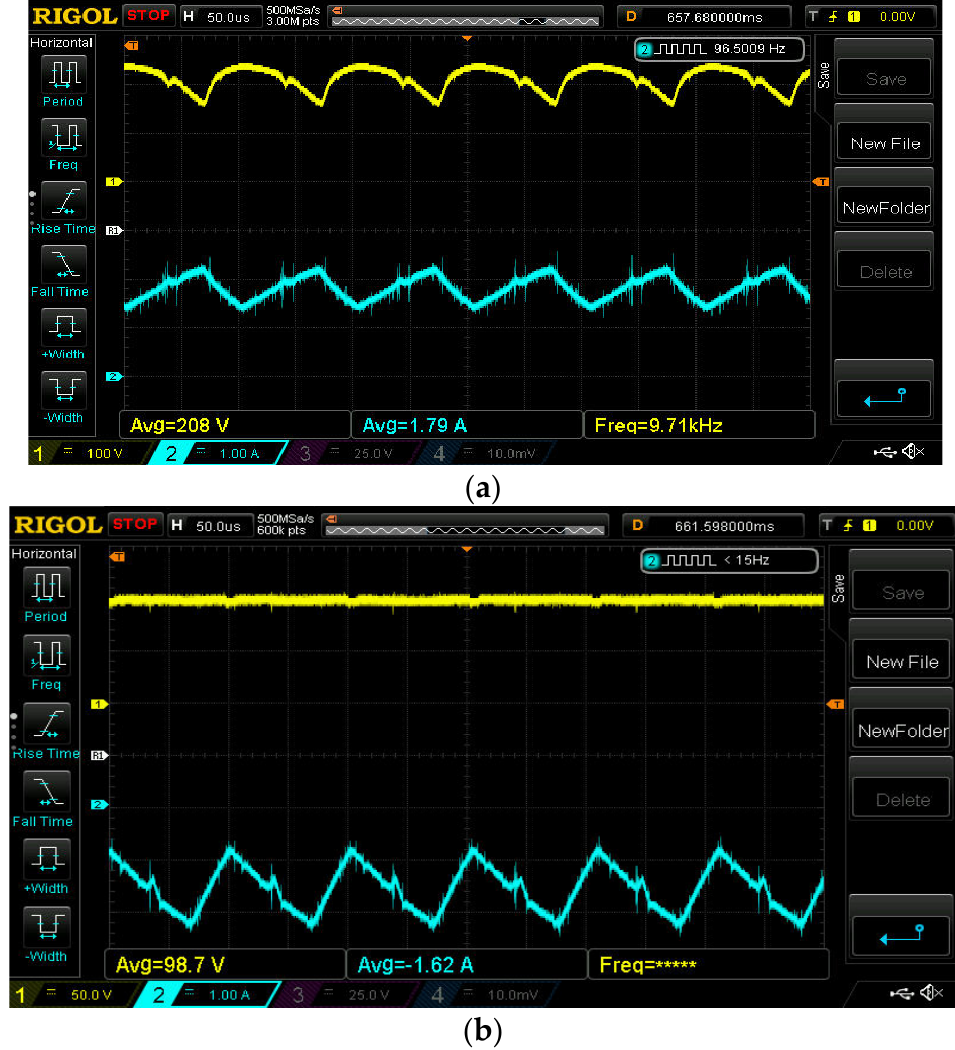
Figure 9. The functioning of the converter in the ESS charging domain: ( a ) Experimental Wave Form of PV; ( b ) Battery in ESS Charging Domain.